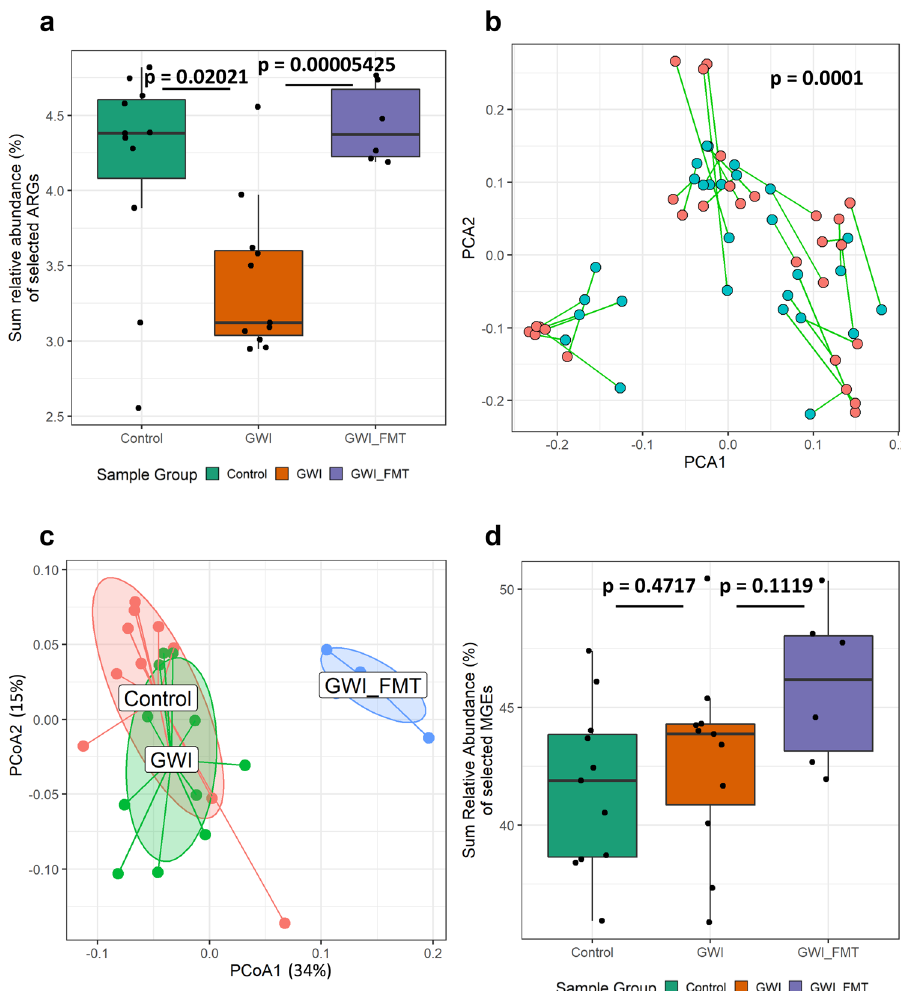
Fig. 1 Distribution of ARGs and MGEs in persistence GWI mouse models. a Box plots showing sum relative abundance (%) of selected antibiotic resistance genes (ARGs) in Control (adult C57BL/6 J mice administered with vehicle, n = 11 biologically independent samples), GWI (adult C57BL/6 J mice administered with GW chemicals, n = 11 biologically independent samples) and GWI_FMT (adult C57BL/6 J mice group exposed to GW chemicals followed by Fecal Microbiota Transfer (FMT) treatment, n = 6 biologically independent samples). Median values of 4.38% in Control, 3.12% in GWI, and 4.37% in GWI_FMT indicated by solid black lines. b Procrustes rotation analysis comparing resistome (blue) and microbiome (red) changes using PCA ordinations, ( X -axis: PCA1, Y -axis: PCA2, PROTEST, M 2 = 0.4302, p = 0.0001). c PCoA of Bray-Curtis dissimilarity between ARG and Taxa pro fi les across sample groups. Principal coordinate axes PCoA1 (34%) and PCoA2 (15%) are calculated to explain 49% of variance detected. Lines connect points from the center of gravity of each sample group. d Box plots showing sum relative abundance (%) of selected mobile genetic elements (MGEs) Control, GWI and GWI_FMT. Boxes in the box plots indicate interquartile range. Error bars in the box plots extend to the most extreme values within 1.5 times the interquartile range. Outlier data points are represented by black dots drawn outside of the box plot. p -values were determined using PROTEST or Welch ’ s t -test where p < 0.05 was considered statistically signi fi